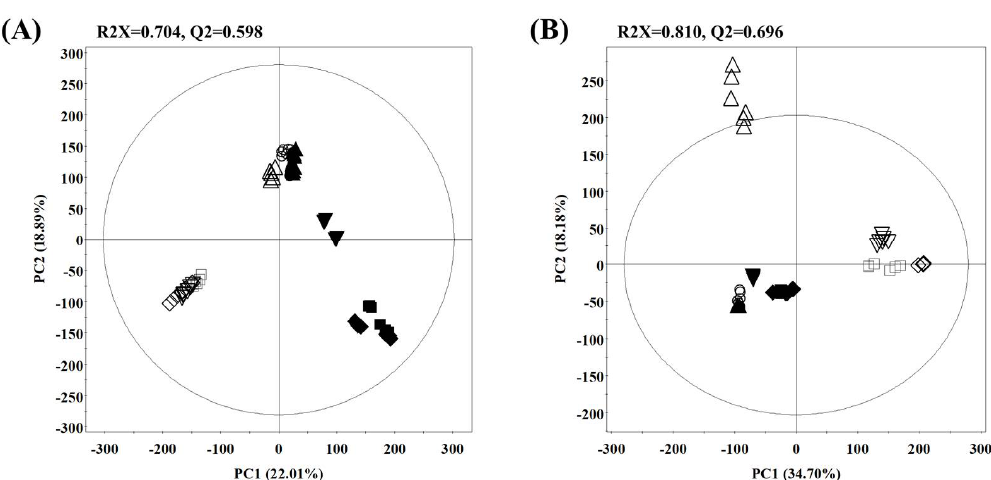
Figure 1. Principal component analysis (PCA) score plot from the ( A ) UHPLC–LTQ–Orbitrap–MS/MS and ( B ) GC–TOF–MS data sets of rice koji fermented with Aspergillus cristatus or A. oryzae . (filled symbols, A. cristatus ; unfilled symbols, A. oryzae ; ●, ○ , 0 day; ▲ , △ , 2 day; ▼ , ▽ , 4 day; ■ , □, 6 day; ◆ , ◇ , 8 day).